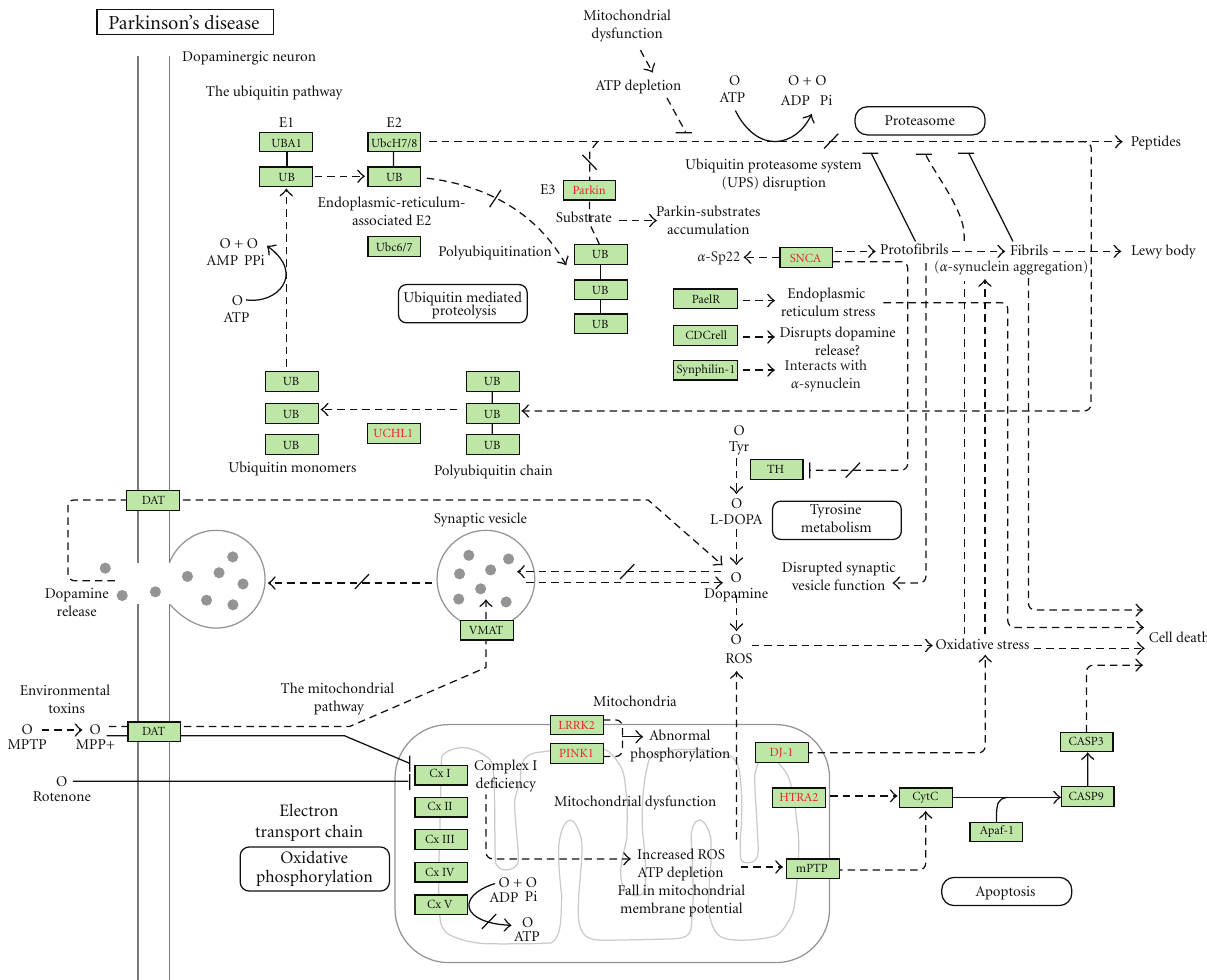
Figure 2: Pathway showing genes involved in Parkinson’s disease (Courtesy: KEGG pathway).